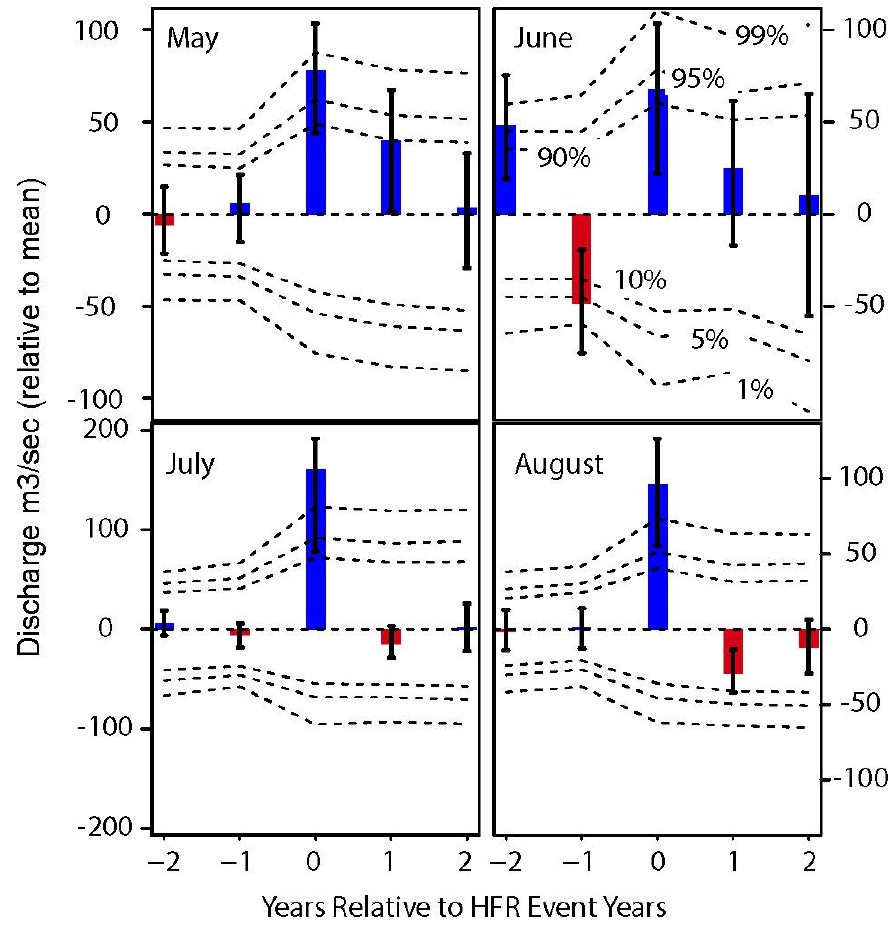
Figure 4. Superposed epoch analysis of the H20 “high” FR (HFR) years vs. May–August monthly streamflow. The dashed lines indicate the statistically significant thresholds (1%, 5%, 10%, 90%, 95% and 99%), while the uncertainty intervals are the 5th and 95th percentiles of monthly discharge.